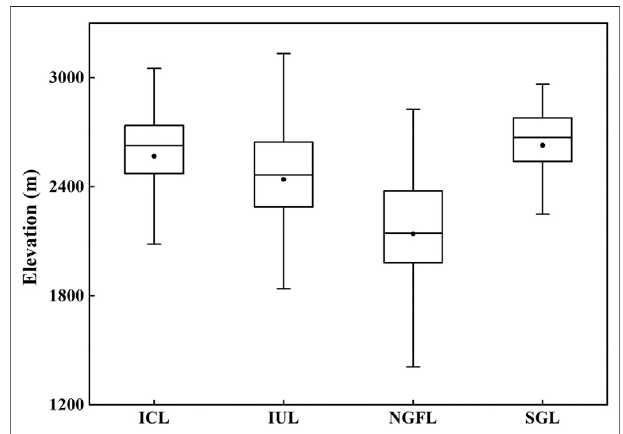
FIGURE4| Glaciallakeelevationbytypein2019.Thedotsrepresentthe mean value.